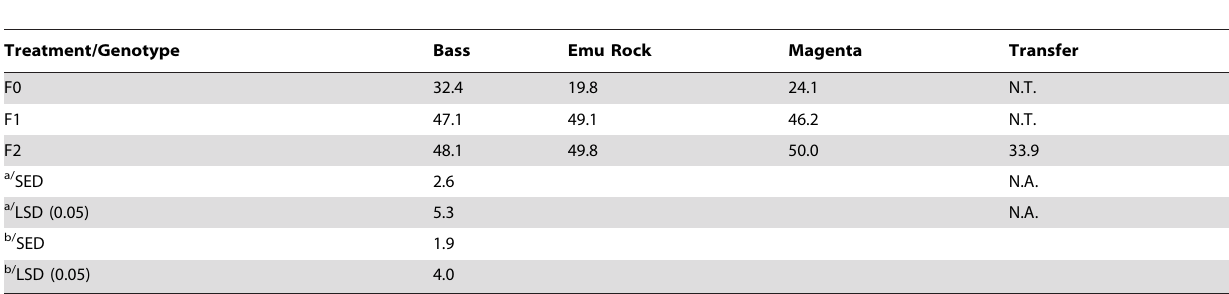
Table 5. Mean SPAD units of chlorophyll content per unit leaf area of wheat genotypes Emu Rock, Magenta and Transfer and barley genotype Bass assessed under fertiliser treatments F0, F1 and F2 in Experiment 4.